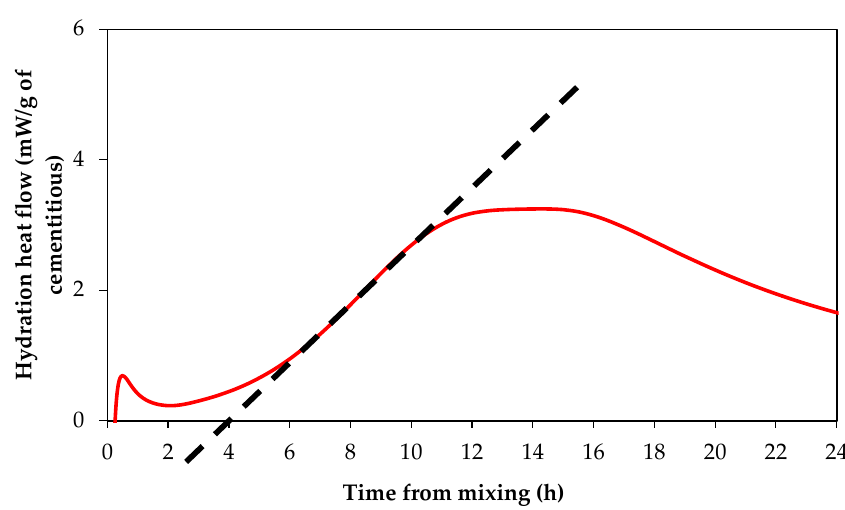
Figure 1. Schematic method of determining the induction period.